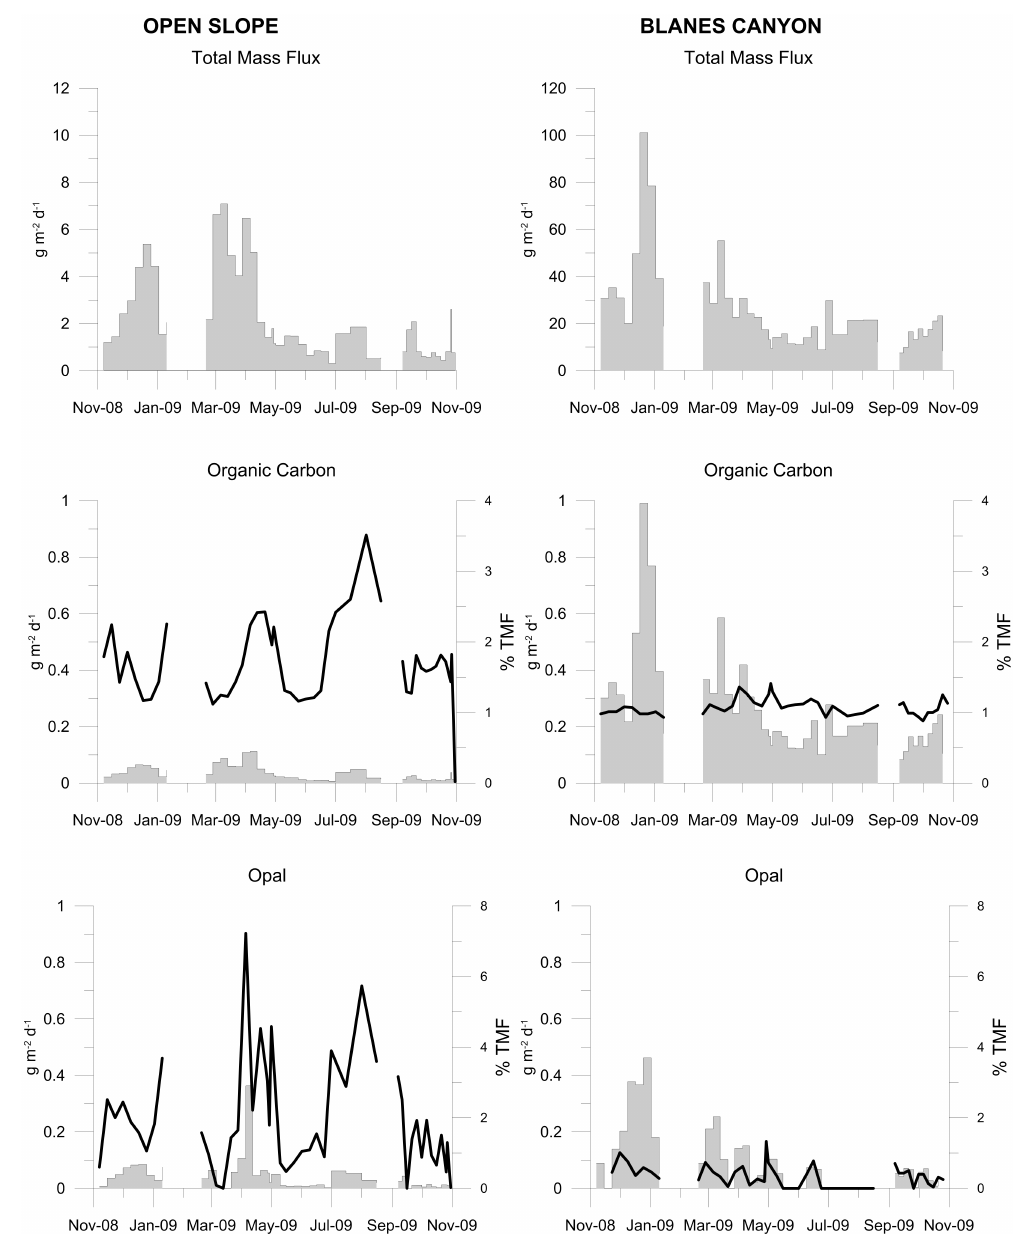
Fig. 3. Time series of total mass, organic carbon and opal fluxes (mgm − 2 d − 1 ) and relative organic carbon and opal contribution (black line represents the % of the compound to TMF) from the sediment traps in the Blanes canyon and the adjacent open slope at 1200m